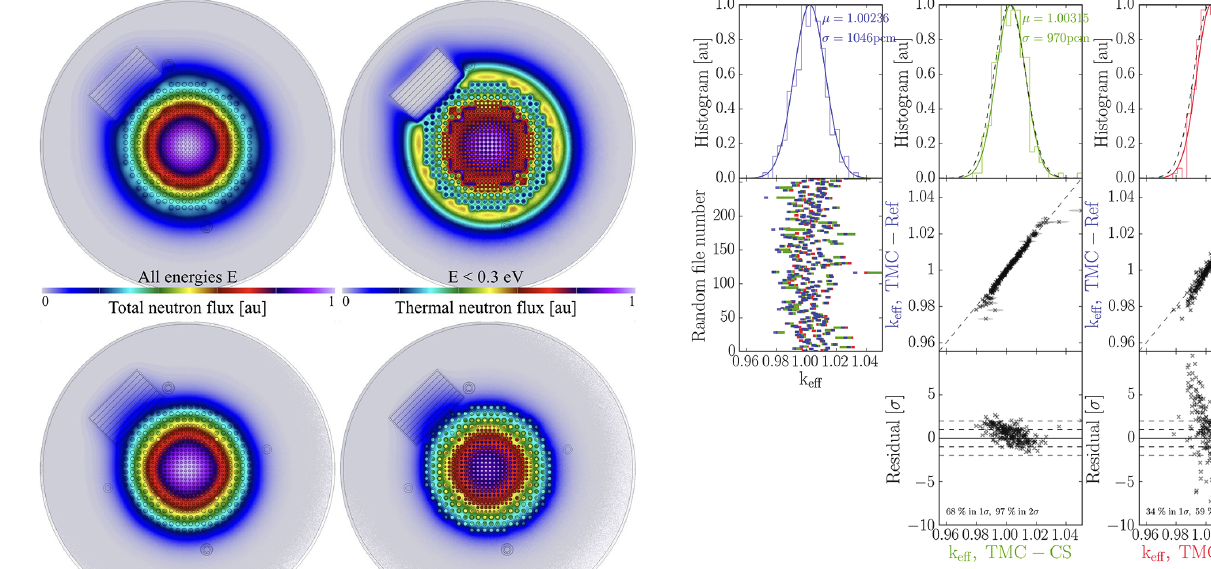
Fig. 5. k eff distribution associated to 56 Fe uncertainty. The plots on first line respectively present the results of the TMC-Ref , TMC-CS and TMC-sensi approaches. The second line corre- sponds to the k eff values for each random file ( 1 st column) and the agreement between the approaches ( 2 nd and 3 rd column). The third line presents the associated